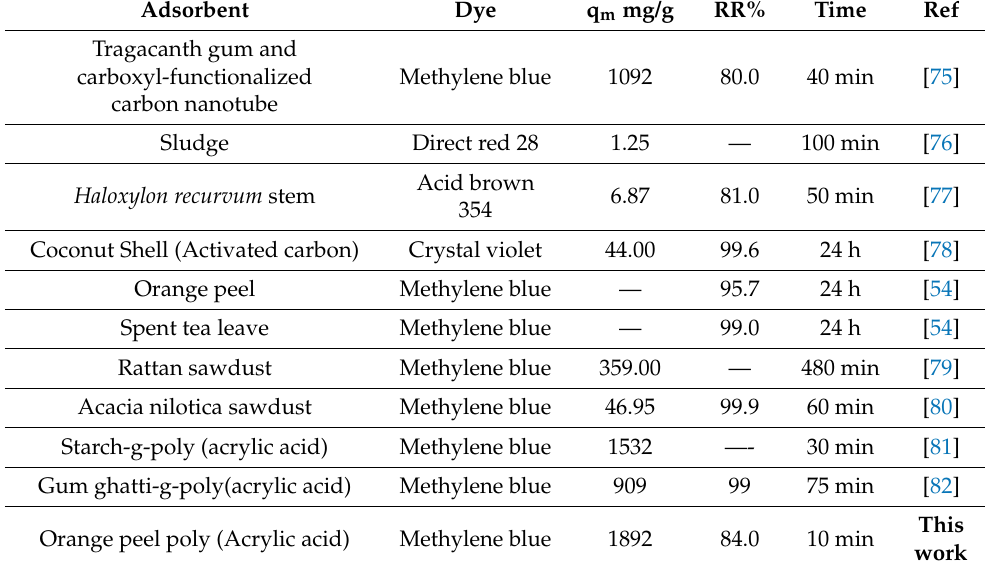
Table 6. Comparison between OP-PAA and some other previously reported dyes’